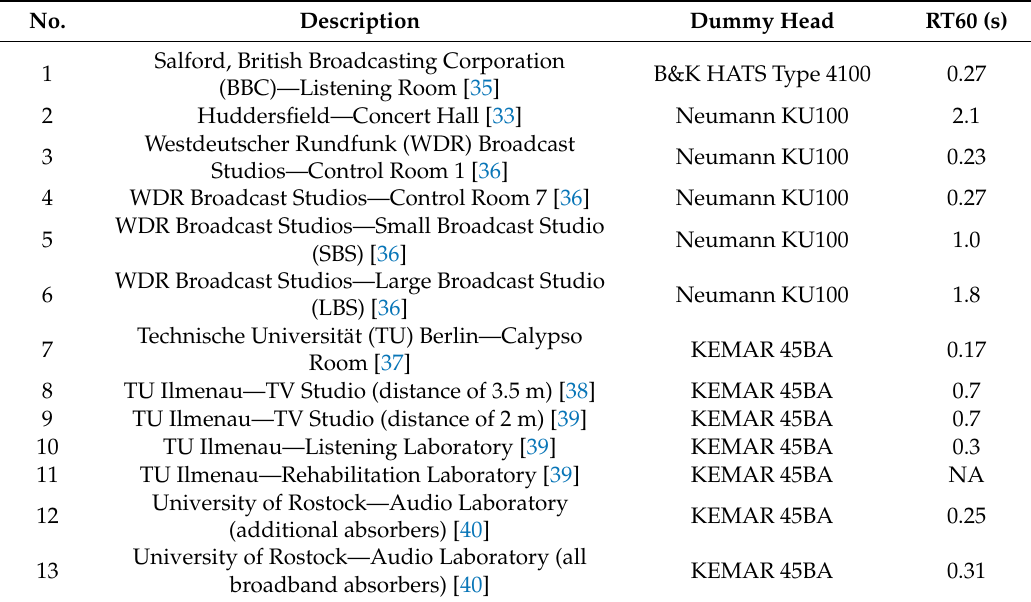
Table 2. The binaural-room-impulse-response (BRIR) sets used in the study (adapted from [13]).